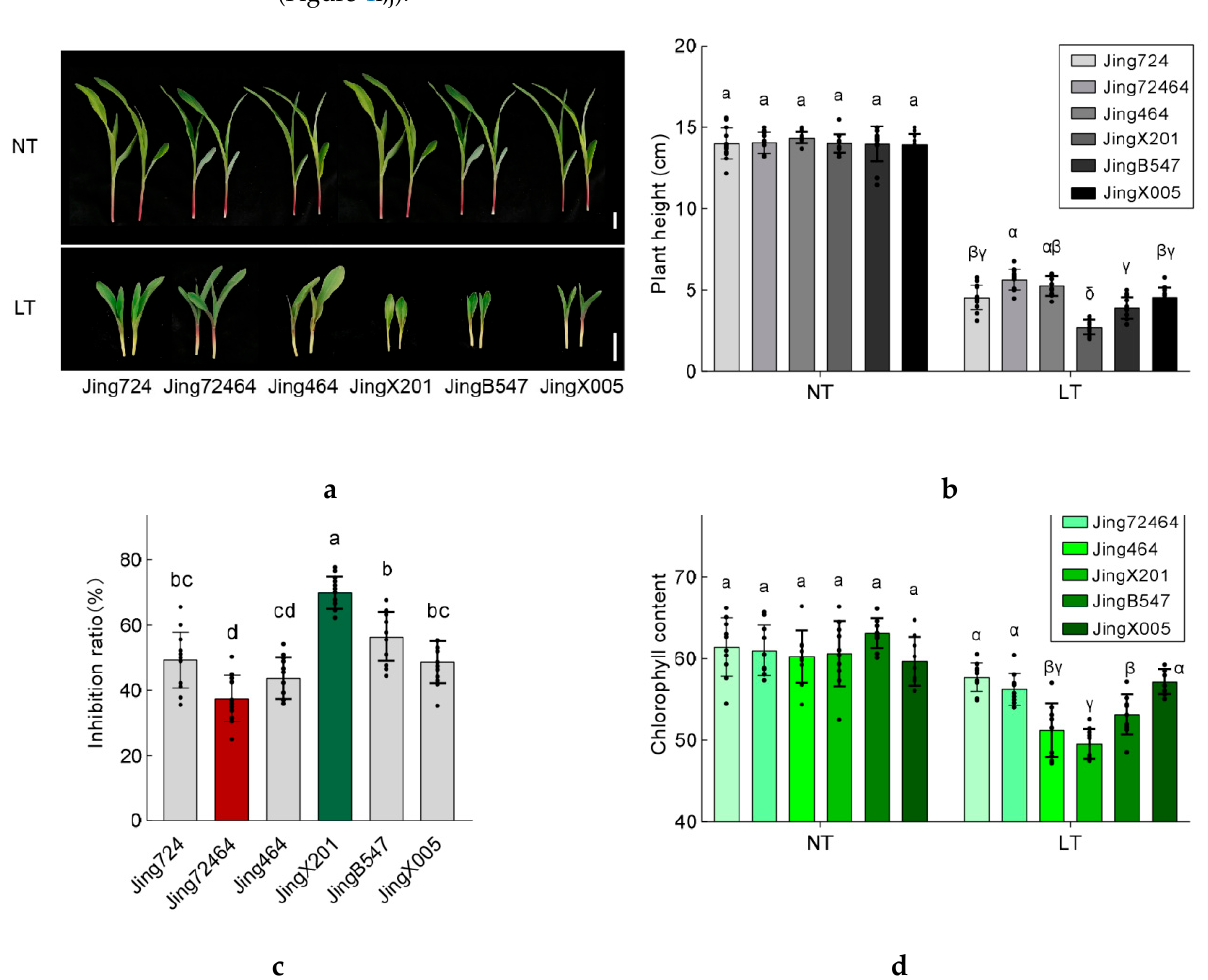
Figure 2. Variation in seedling establishment among maize accessions under low temperature. ( a ) Plant morphology of seedlings with the first true leaf expanded. Scale bar, 2 cm. ( b ) Plant height of 6 maize inbred accessions in the filed condition under LT or NT. Data represent mean values of three independent replicate ( n > 12). ( c ) Inhibition rate of LT on plant height. Data were calculated as the plant height in LT versus the means in NT. ( n > 12). ( d ) Chlorophyll content of 6 maize inbred accessions in the filed condition under LT or NT. Data are mean ± s.e.m. ( n = 10). ( b – d ) Significant differences were labeled with different Roman (a, b) or Greek letters ( α , β ).